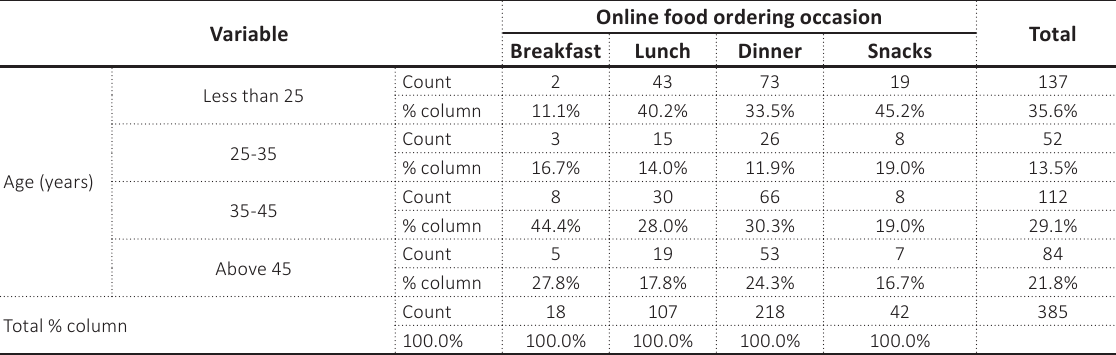
Table 15. Cross-tabulation among age and online food ordering